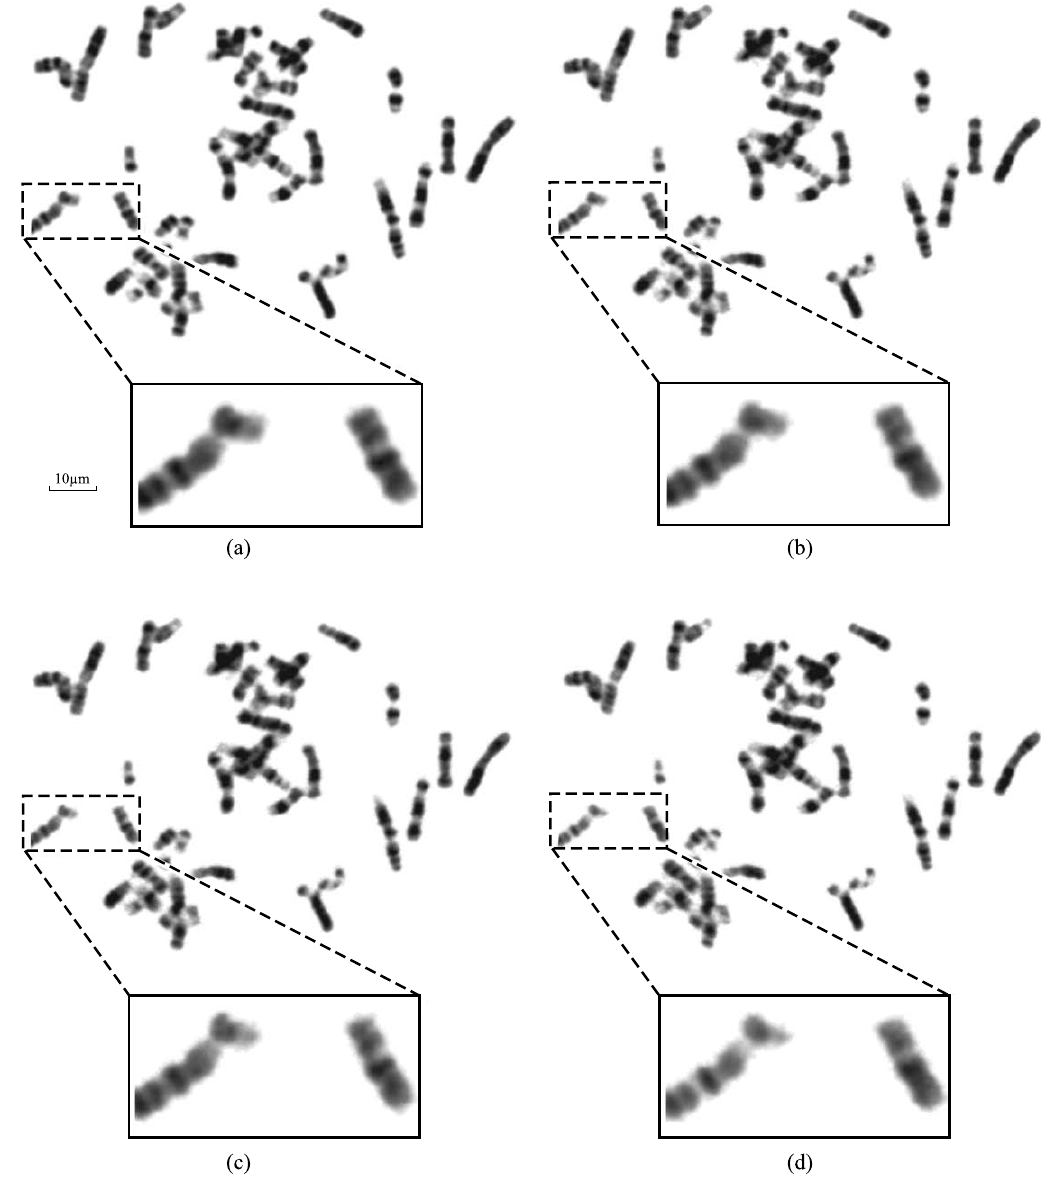
Fig. 9. Microscopic images acquired from the one sample under the 40 × objective and different value s : (a) s =0.6 (b) s =0.8 (c) s =1.0 (d) s =1.2. diagnosis. Figures 9(c) and 10(c) show a decreased image quality and band patterns sharpness, but it is still recognizable. However, the band patterns under s = 1.2 in Figs. 9(d) and 10(d) are barely recogniz- able in which bands A and B are difficult to be separated with each other even using post-processing